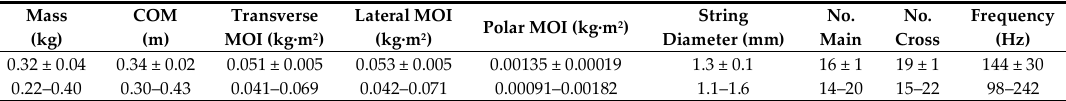
Table 3. Inertial and string properties and vibration frequency. Mean ± Standard Deviation,